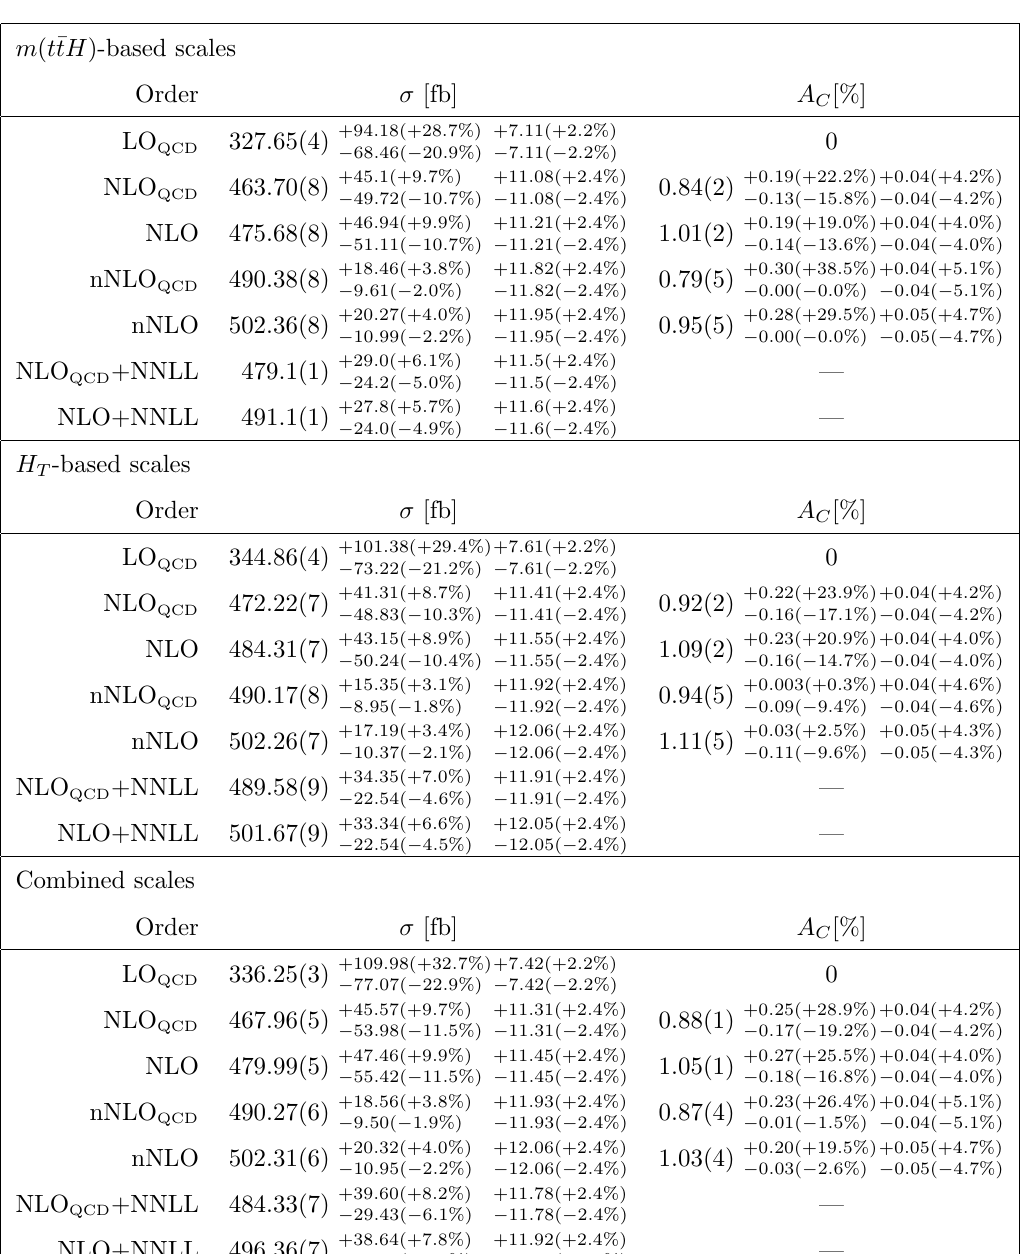
Table 3 . Total cross section and charge asymmetry for t (cid:22) tH production. Same structure as in table 1.